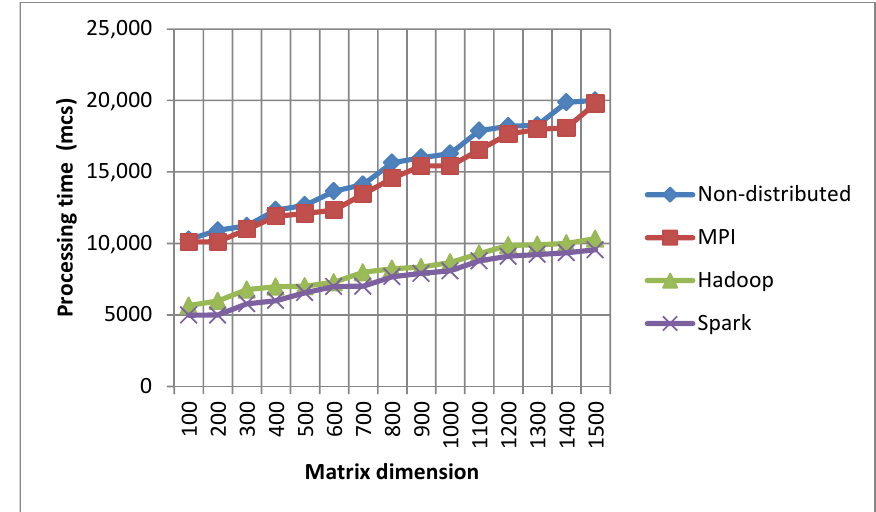
Figure 15. Dependence of the processing time of recommendations to users on the dimension of input data for unmodified SVD method (1); modified method based on MPI (Message Passing Interface) technology (2) modified method based on Hadoop technology (3); modified method based on Spark technology (4).